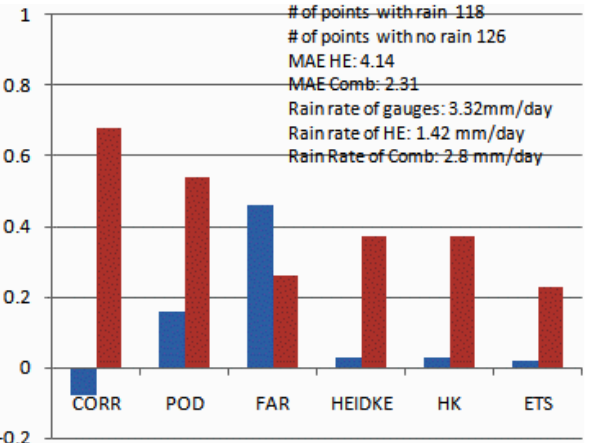
Fig. 18. Statistical evaluation of 12 July 2009 for HE (blue) and COMB